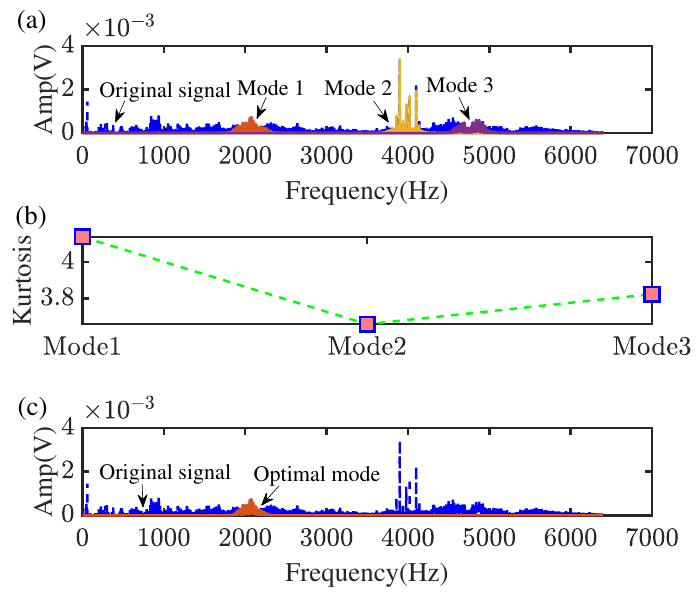
Figure 12. Vibration signal of rolling element defective bearing: ( a ) time waveform; ( b ) Fourier spectrum.